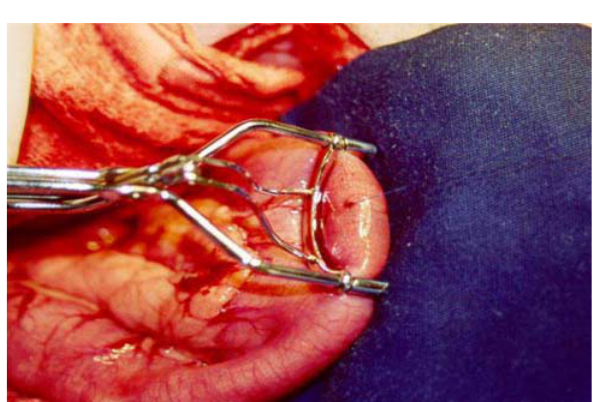
FIGURA 2: Curvador de cílios marcando a área da lesão, na segunda porção duodenal.